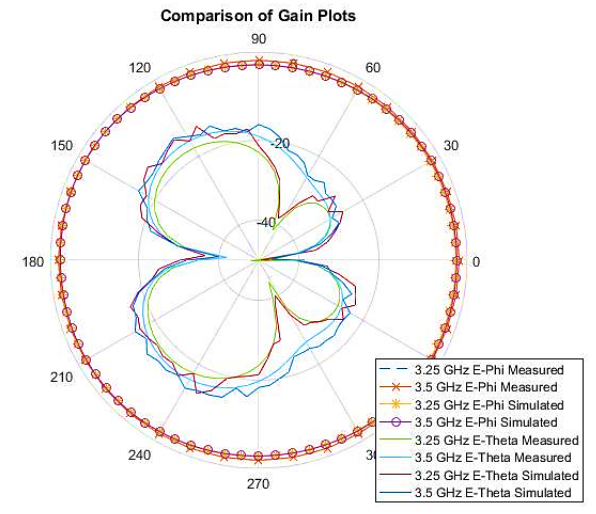
FIGURE 8. Comparison of Simulated and Measured Far-Field Co-Polar and Cross-Polar Radiation Pattern The Radiation Efficiency vs Frequency (2 GHz – 5 GHz) is